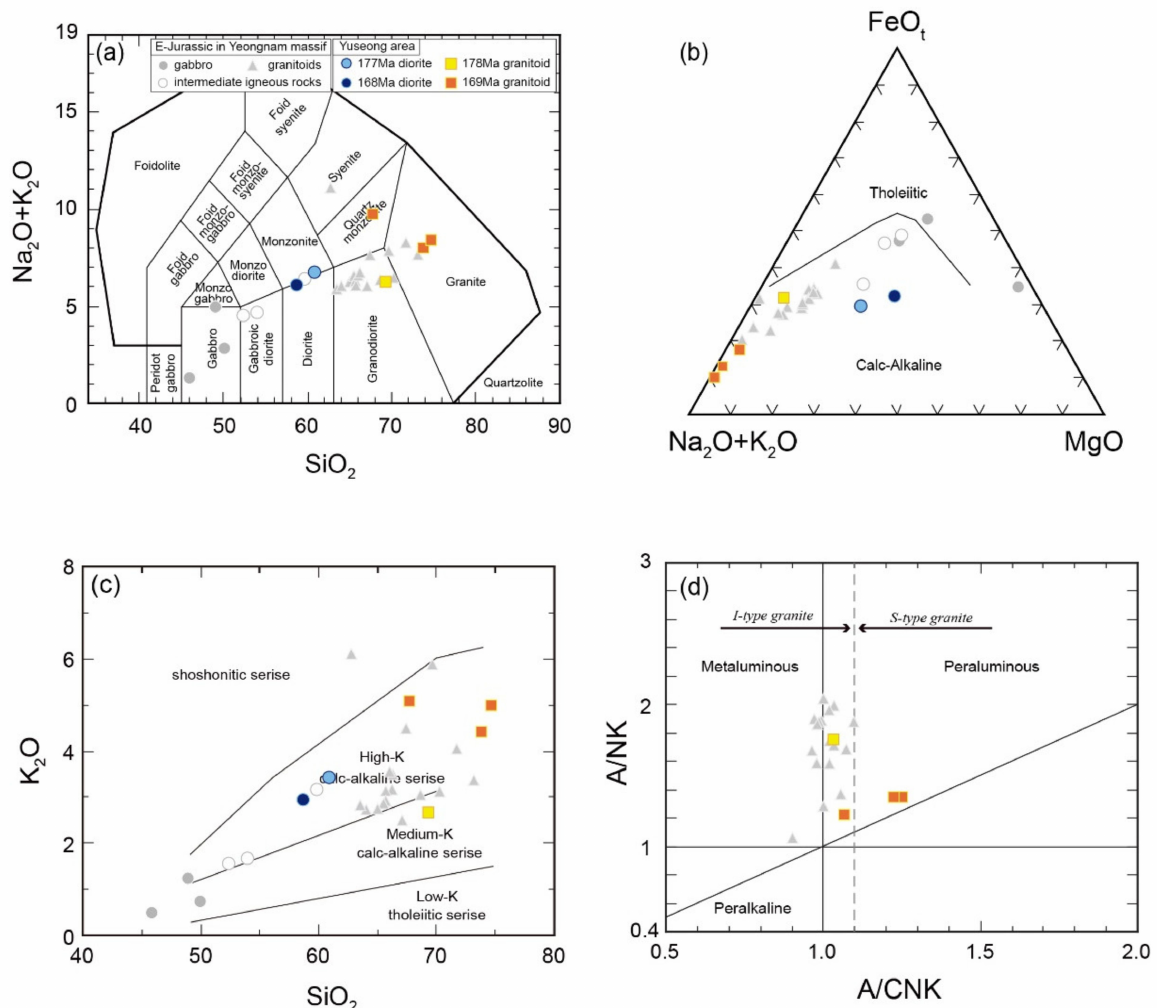
Figure 3. Chemical classification using major elements of the Jurassic diorite and granitoids in the Yuseong area together with Early Jurassic igneous rocks in the YM in the ( a ) total alkali (Na 2 O + K 2 O) vs. silica (SiO 2 ) diagram (after Middlemost [33]), ( b ) FeOt-Na 2 O + K 2 O-MgO diagram (after Irvine and Baragar [34]), ( c ) K 2 O vs. SiO 2 diagram (after Peccerillo and Taylor [34,35]), and ( d ) A/NK vs. A/CNK diagram (after Maniar and Piccoli, [36]). E-Jurassic: Early Jurassic. Data sources of Early Jurassic igneous rock in the YM are from Kee et al. [1] and Kim et al.